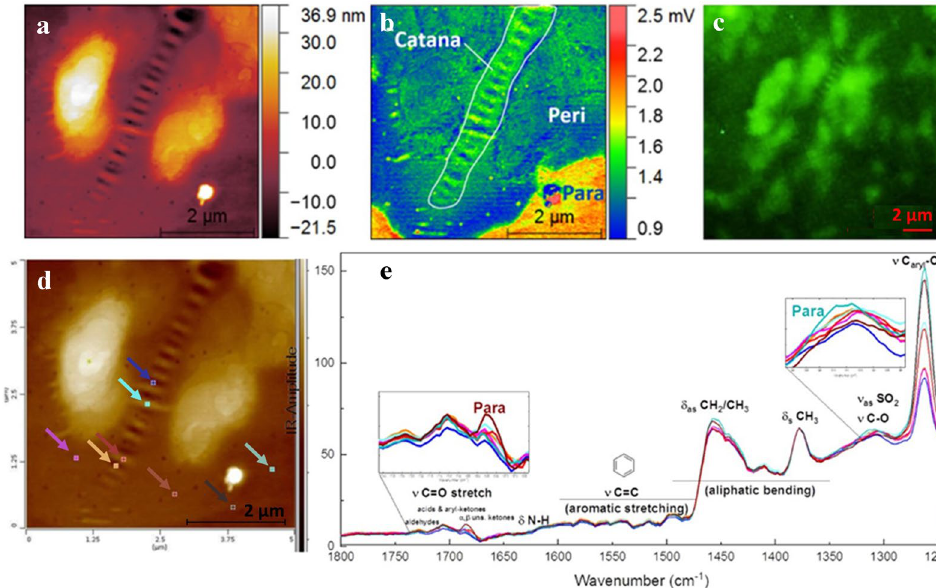
Figure 4. Single surface microstructure visualized with spectroscopic and microscopic techniques. ( a ) AFM topographic image of a single microstructure with respective ( b ) AFM-IR image at fixed wavelength 1262 cm −1 ( c ) corresponding fluorescence image of a single microstructure, exhibiting strong fluorescence on catana and peri phase, ( d ) AFM Image with colour-marked areas and their € localized AFM-IR spectra with the same colour